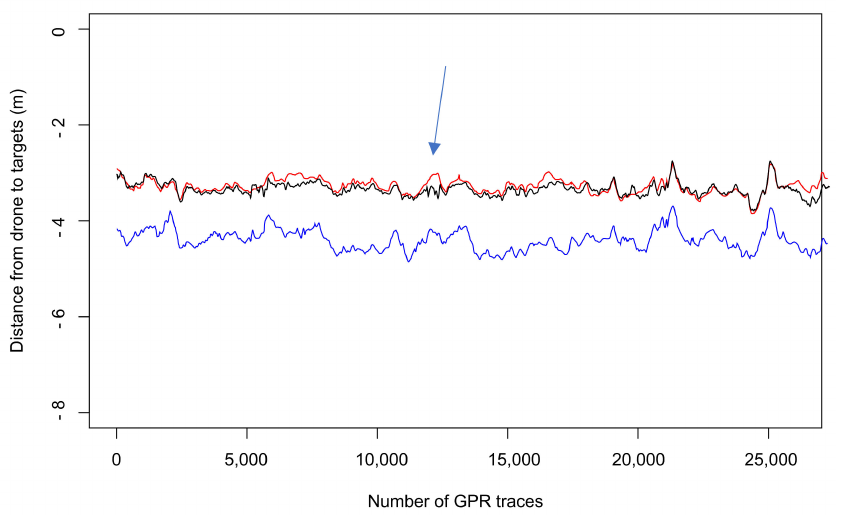
Figure 12. Data was extracted from Figure 11 by manually picking the air–snow interface (in red) and the snow–ground interface (in blue). The black line was retrieved by the rangefinder sensor log, appropriately synchronized with the GPR data. In some zones, the unclear reflection made the picking underestimate the flight altitude by 10–20 cm, up to 50 cm at a point indicated by an arrow. After subtracting the flight altitude from the radargrams, the GPR sections become more familiar, similar to the ground-based ones. Four parallel sections are shown in Figure 13, and their position is highlighted in Figure 5. The electromagnetic wave velocity was estimated with Looyenga’s equation [27–29] to be about 0.26 m/ns, considering an average snow density of 180 kg/m 3 , since manual measurements reported values from 150 to 210 kg/m 3